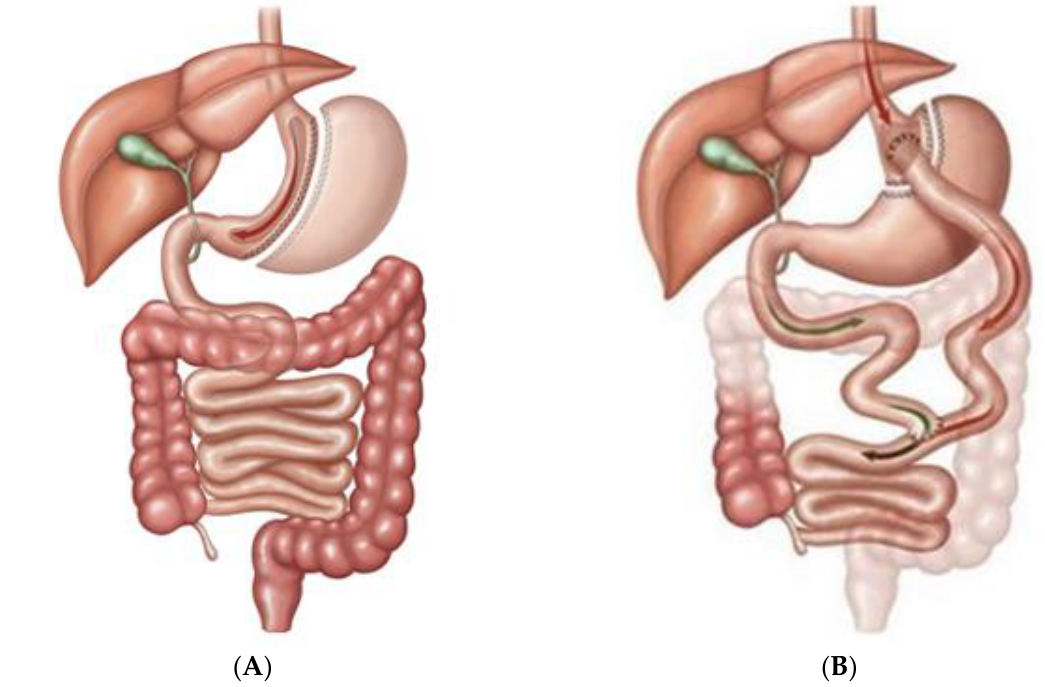
Figure 1. Schematic drawing of Sleeve Gastrectomy and Roux-en-Y Gastric bypass. ( A ) Sleeve Gastrectomy (SG). Representation of a common human sleeve gastrectomy (SG) procedure. The SG is a surgical procedure including a reduction of final gastric volume, since most of the gastric major curvature is resected. The stomach is reduced to a cylindrical pouch removing most of the fundus, stomach-corpus and antrum. The pylorus and minor curvature is preserved. SG reduces the initial stomach volume by approximately 15–20%. In animal models this configuration is maintained since the final gastric pouch volume and valves are preserved. ( B ) Roux-en-Y Gastric Bypass (RYGB). Representation of a common human roux-en-Y gastric bypass (RYGB) surgery. This includes a transverse section of the stomach performed from the major to the minor curvature, configuring a gastric pouch. This pouch of the stomach continues to the food handle with an alimentary bulb, which continues with the medium portion of the jejunum. RYGB, a mixed malabsorptive and restrictive technique, excludes the antrum and the proximal intestine to aliments by bypassing the duodenum and the initial part of the jejunum. This includes biliopancreatic secretion, which determines the malabsorptive component. The biliopancreatic bulb connects with the mid jejunum. In rats, the model was reproduced similarly with minor modifications according to the animal anatomy. Exempli gratia, the jejunal alimentary bulb was 10 cm due to the usual intestinal medium extension of 80 cm. Original figure seen in https://sagebariatric.com/about-surgery-home/sleeve-gastrectomy (accessed on 22 July 2021).